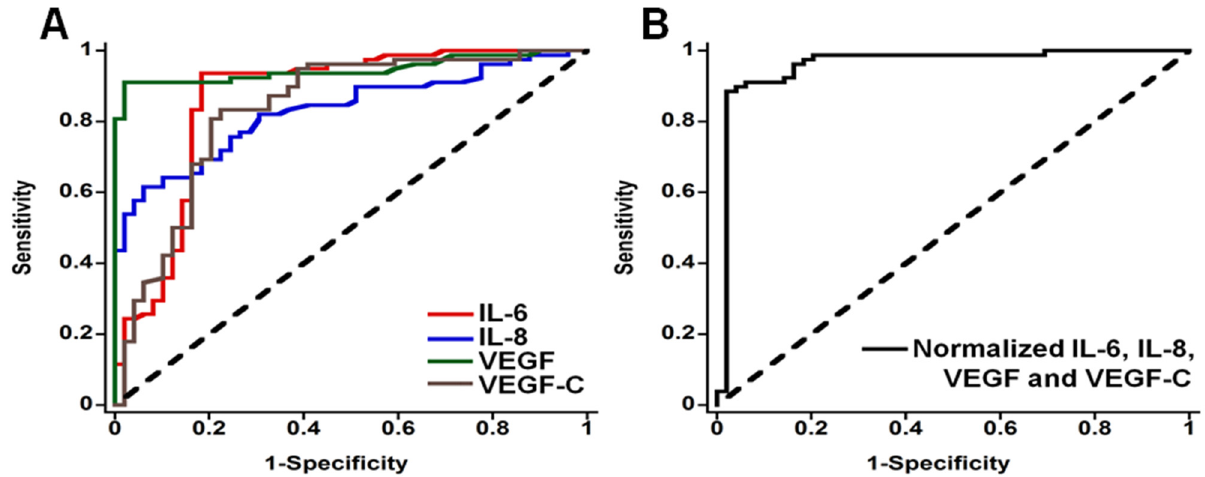
Figure 4. Receiver operating characteristic (ROC) curves for serum assays for ( A ) IL-6, AUC 0.86 (red line), IL-8 with AUC 0.83 (blue line), VEGF with AUC 0.95 (green line), VEGF-C with AUC 0.83 (brown line), and ( B ) mean normalized value for all four proteins, with AUC 0.96. Reprinted from [26]. Copyright 2012 American Chemical Society.